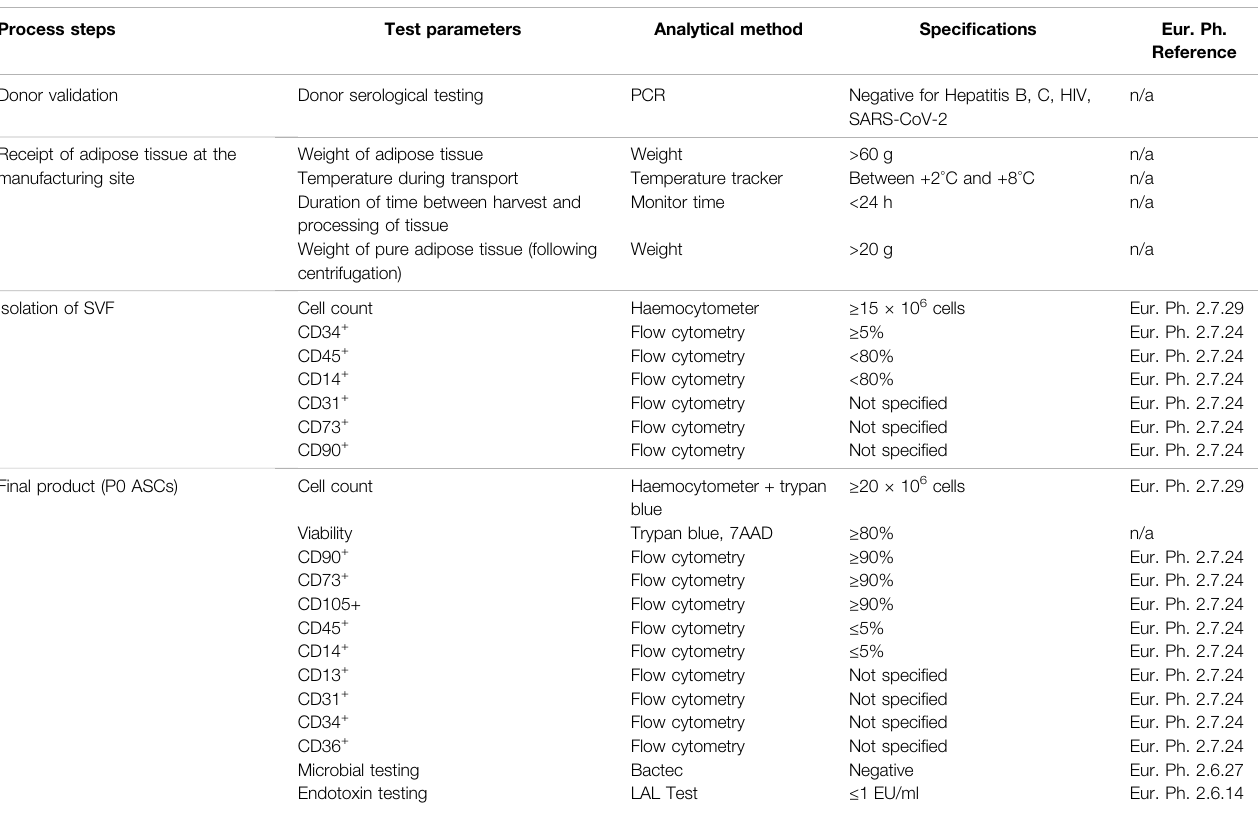
TABLE 2 | Speci fi cations and in process controls for starting material, SVF and fi nal cell product. Process